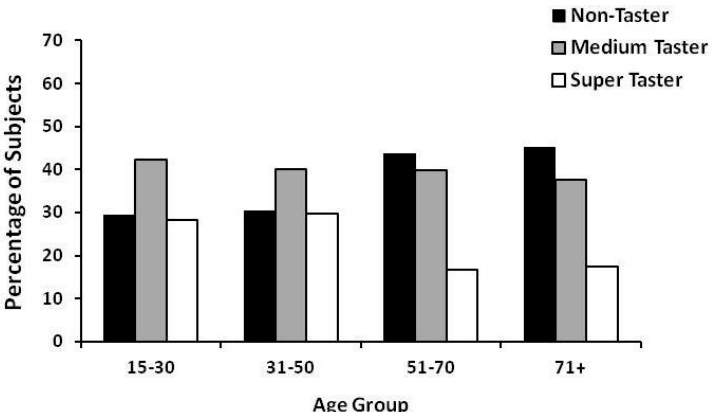
Figure 2. Distribution of PROP taster groups by age in the isolated community of Val Borbera, Northwest Italy. n = 589; sample size per age group: 59 (15–30 years); 191 (31–50 years); 261 (51–70 years); 78 (71+ years). The percentage of non-tasters increased and the percentage of super-tasters decreased in those >50 years of age (by Chi-square analysis; p < 0.001). Unpublished data from Tepper et al. [107].